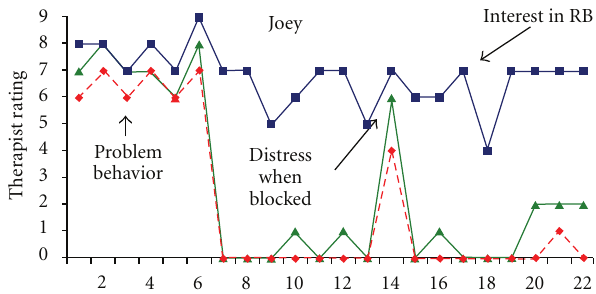
Figure 1: Therapist ratings of Joey’s interest in the repetitive behav- ior (RB) item (i.e., puzzles), distress when access to puzzles was blocked, and intensity of problem